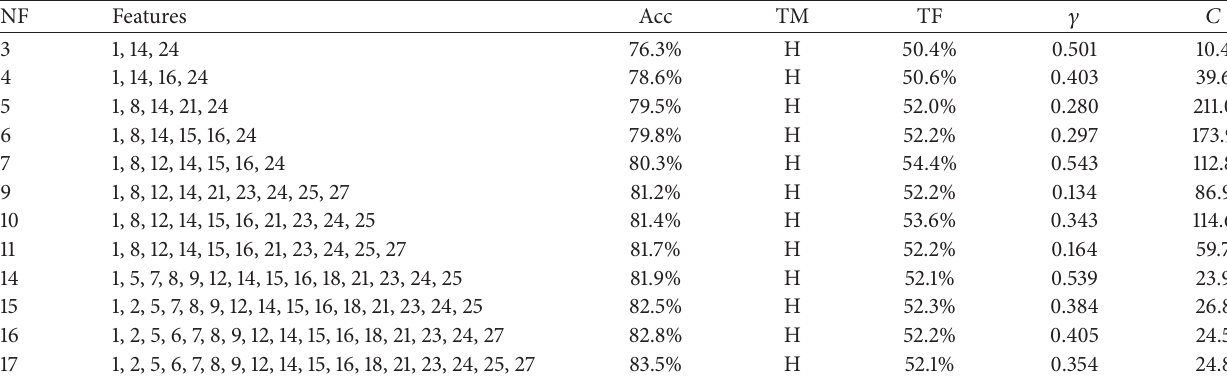
Table 4: Optimal solutions for Run-a of Experiment 2 (Diane 2005 database).